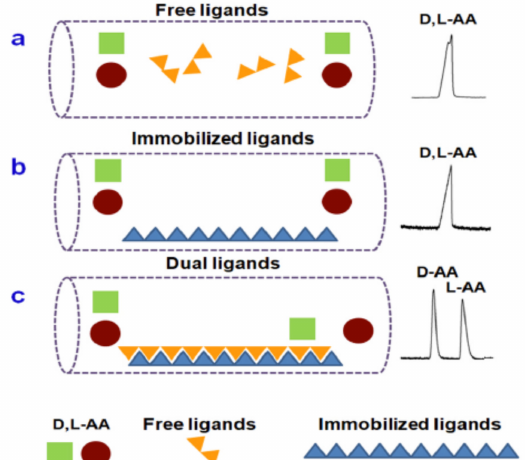
Figure 7. Illustration of enantioseparation mechanism of CLE-CEC by using ( a ) free ligand alone, ( b ) immobilized ligand alone and ( c ) dual ligands. Reproduced with permission from the authors of